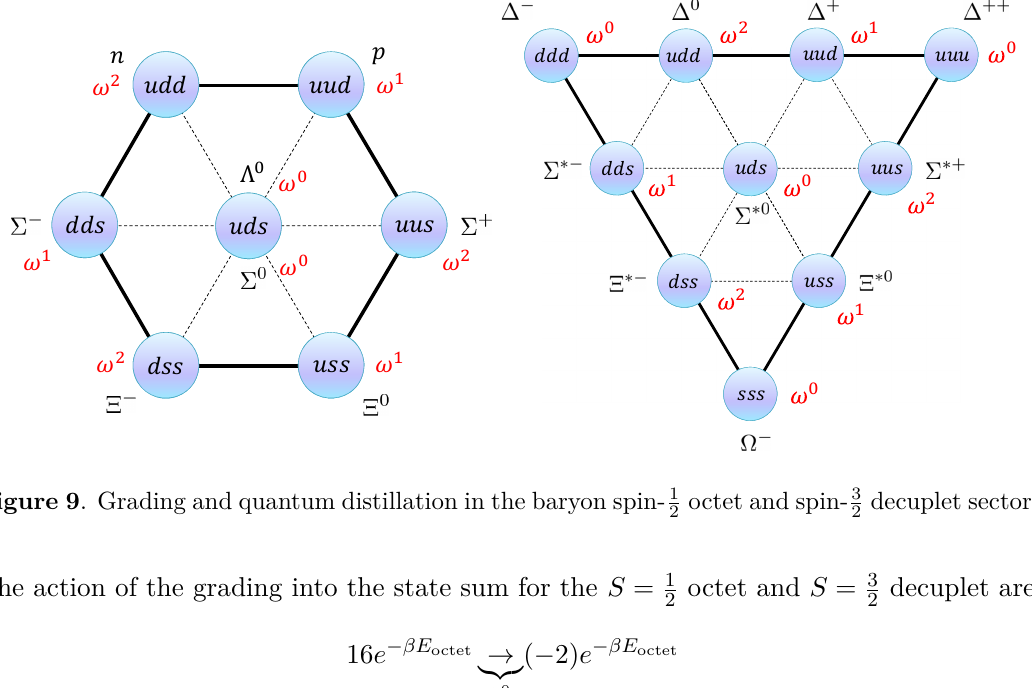
The action of the grading into the state sum for the S = 1